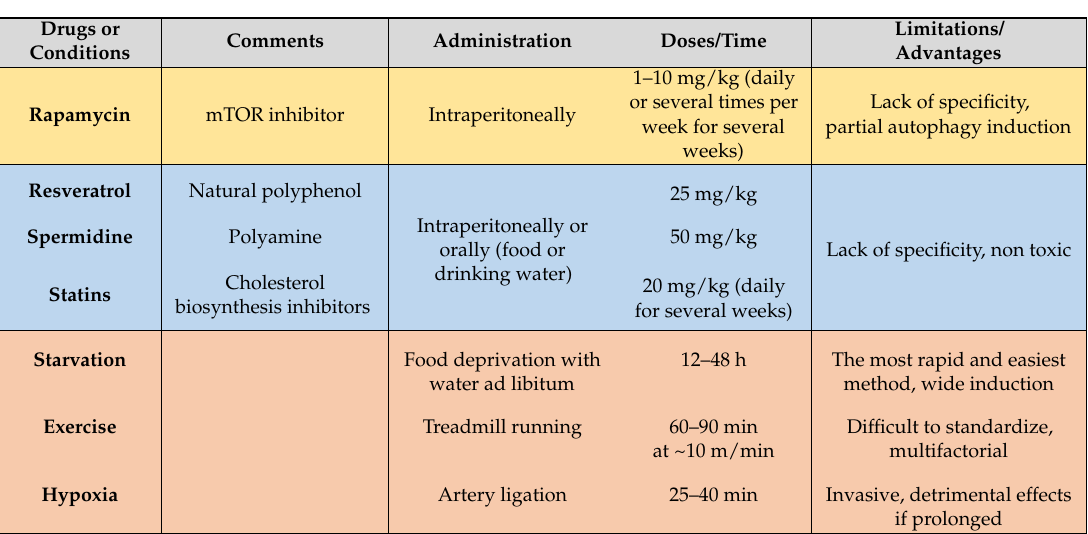
Table 3. Selected autophagy inducers for measuring autophagy flux in